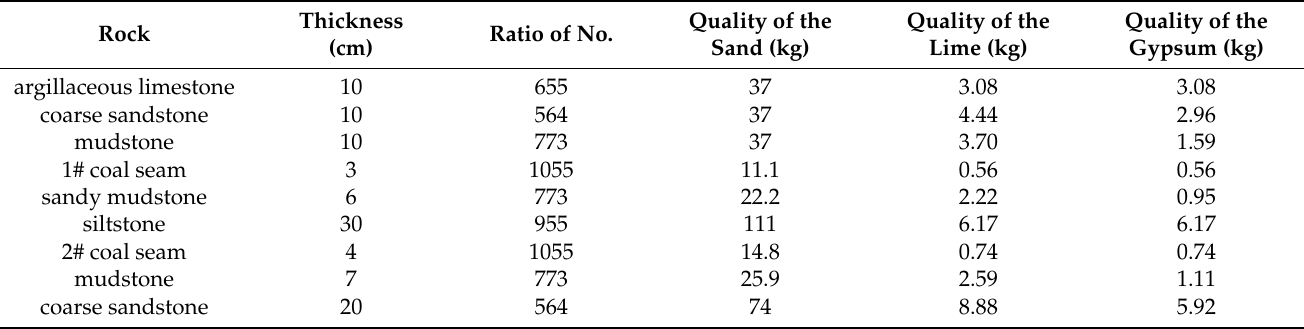
Table 2. Material ratio of similar simulation